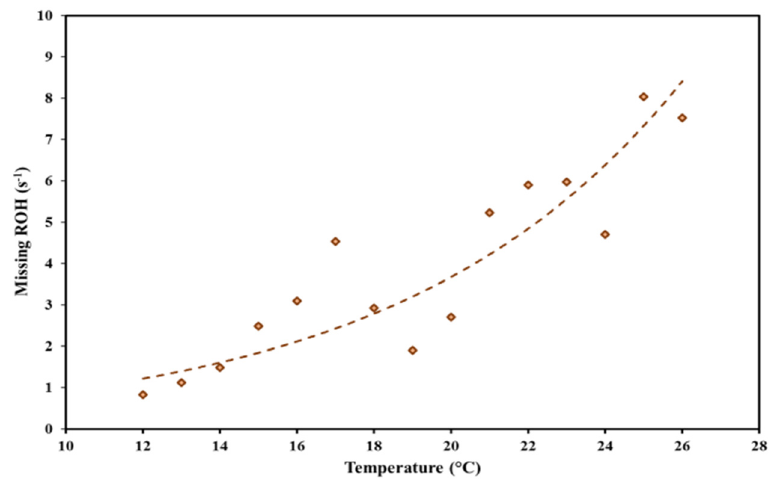
Figure 6. Variability of missing OH reactivity as function of air temperature in the chamber. The regression curve equation is ROH missing = 0.23exp(0.14(T)) (R 2 = 0.8).